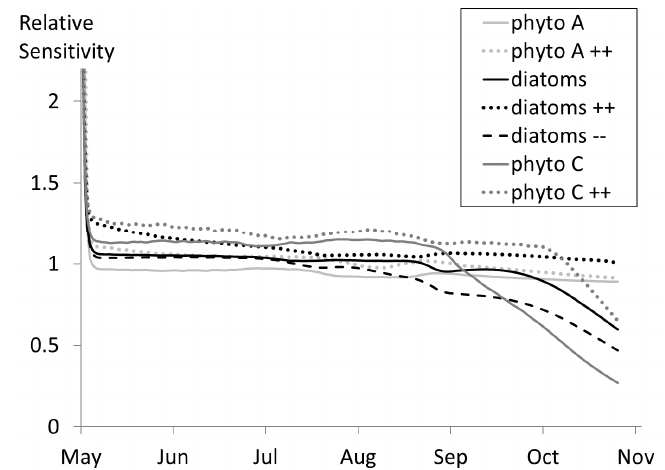
Figure 9. Results of the global sensitivity analysis when increasing (++) or decreasing ( −− ) the initial biomass concentration of rotifers (legend: (A) chrysophytes, cryptophytes (B) diatoms and (C) chlorophytes, dinoflagellates and cyanophytes).